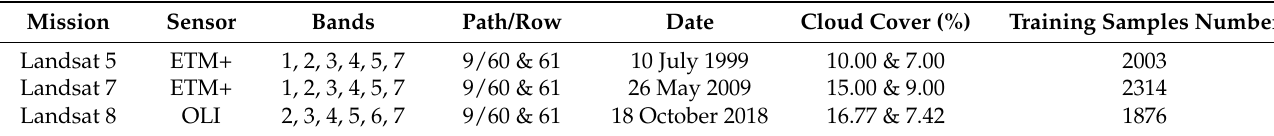
Table 1. Satellite images used in the LULC spatial analysis of the Life and Diversity Zone, Yasuní Biosphere Reserve of the Ecuadorian Amazon Region.